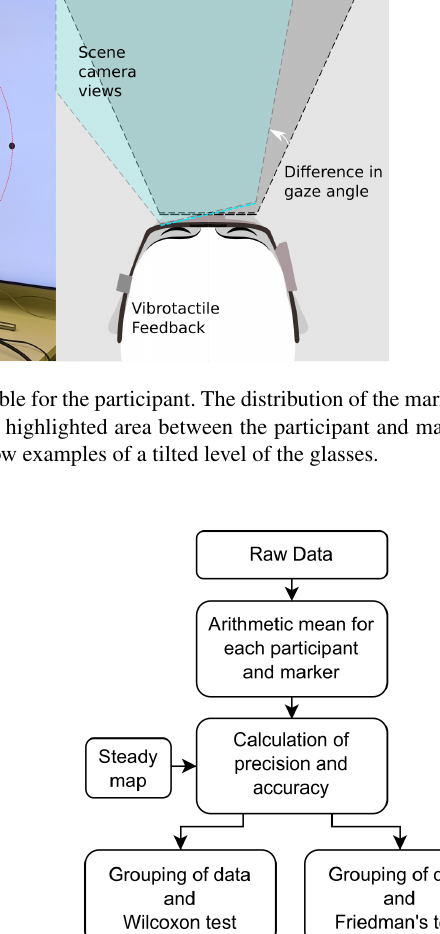
Figure 2. Program flow of the data analysis. Precision and accu- racy were determined and compared with a steady map. Signifi- cance between conditions and measurements was calculated with the Wilcoxon rank sum test and Friedman’s